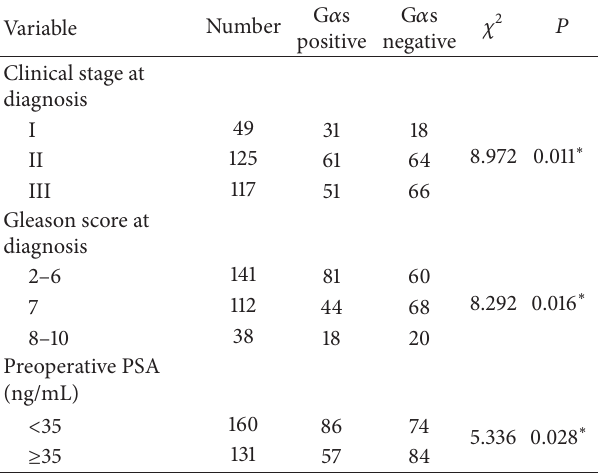
Table 3: Characterization of the cohort of 291 localized prostate cancer samples.